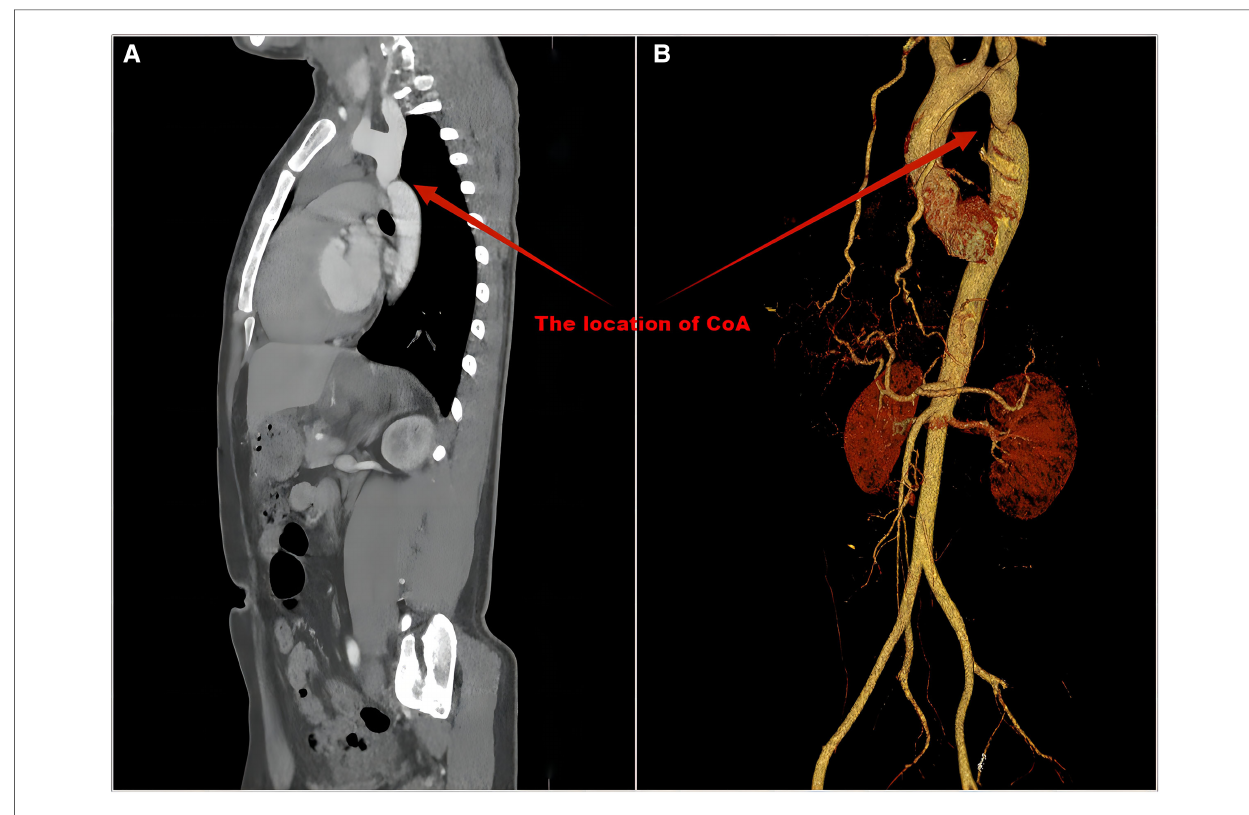
FIGURE 3 CT ( A ) and 3D reconstruction ( B ) of CoA. The precise location, diameter and length of the narrowing can be